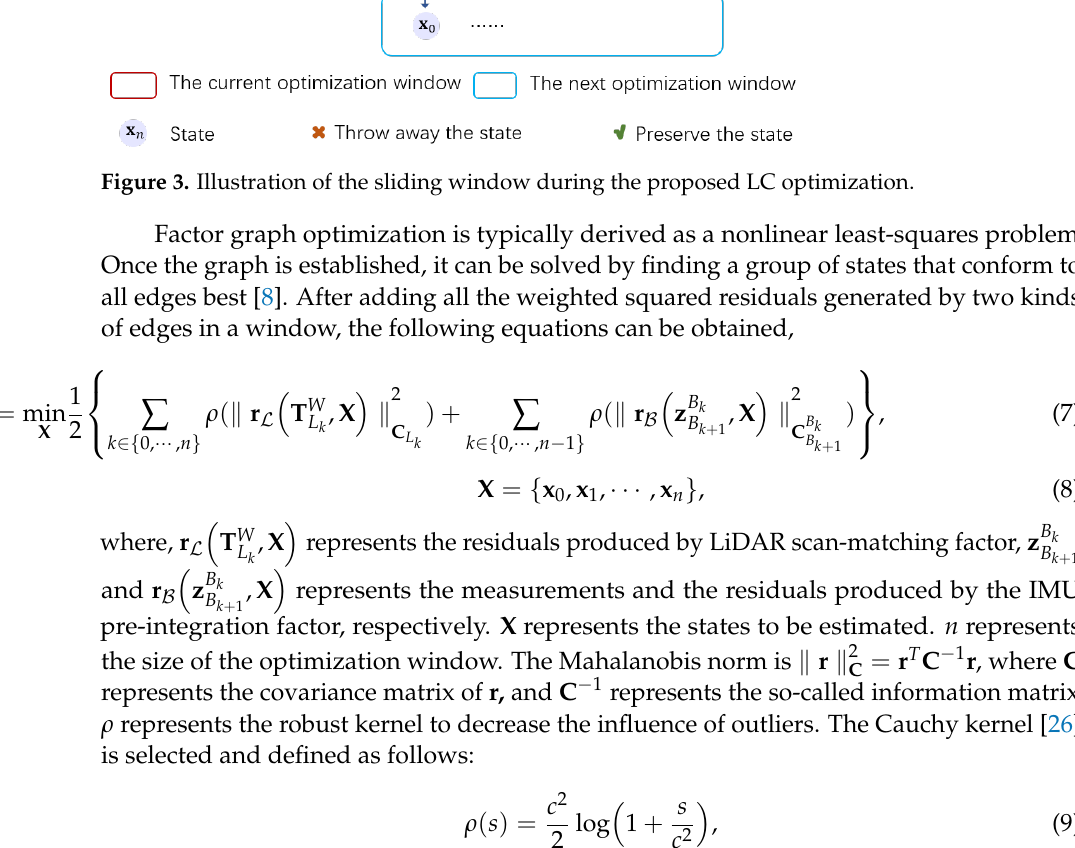
Figure 2. Factor graph of the proposed LC-LIO. The light purple circle represents the state of the IMU frame. There are two types of factors introduced to constrain the states, namely the scan matching factor and IMU pre-integration factor.